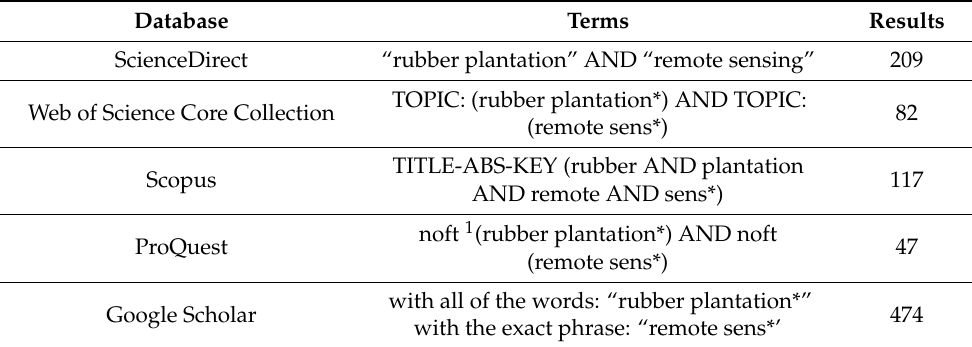
Table 2. List of database with exact search term and results.